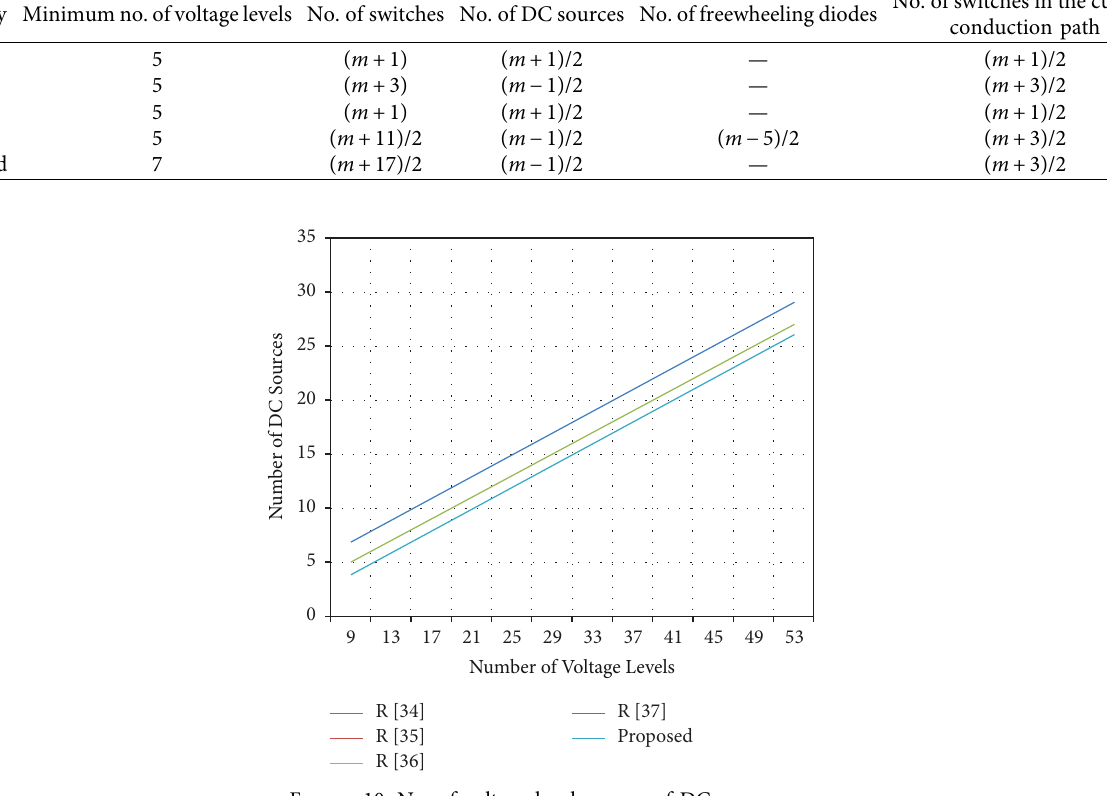
Figure 10: No. of voltage levels vs no. of DC sources.